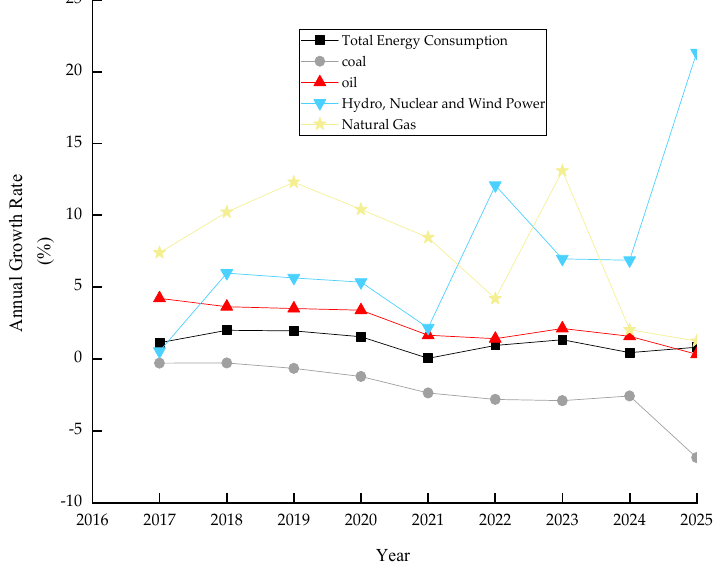
Figure 10. Growth rate of primary energy demand.